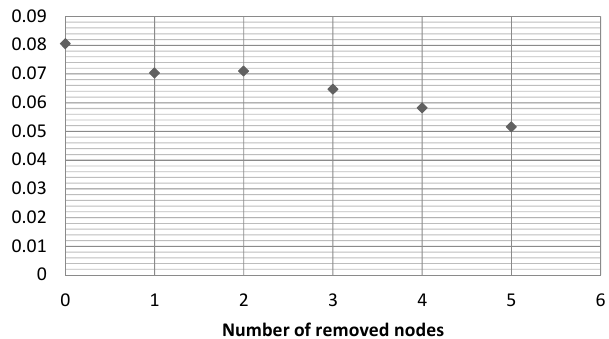
Figure 18. The change of the local network efficiency during analysis.